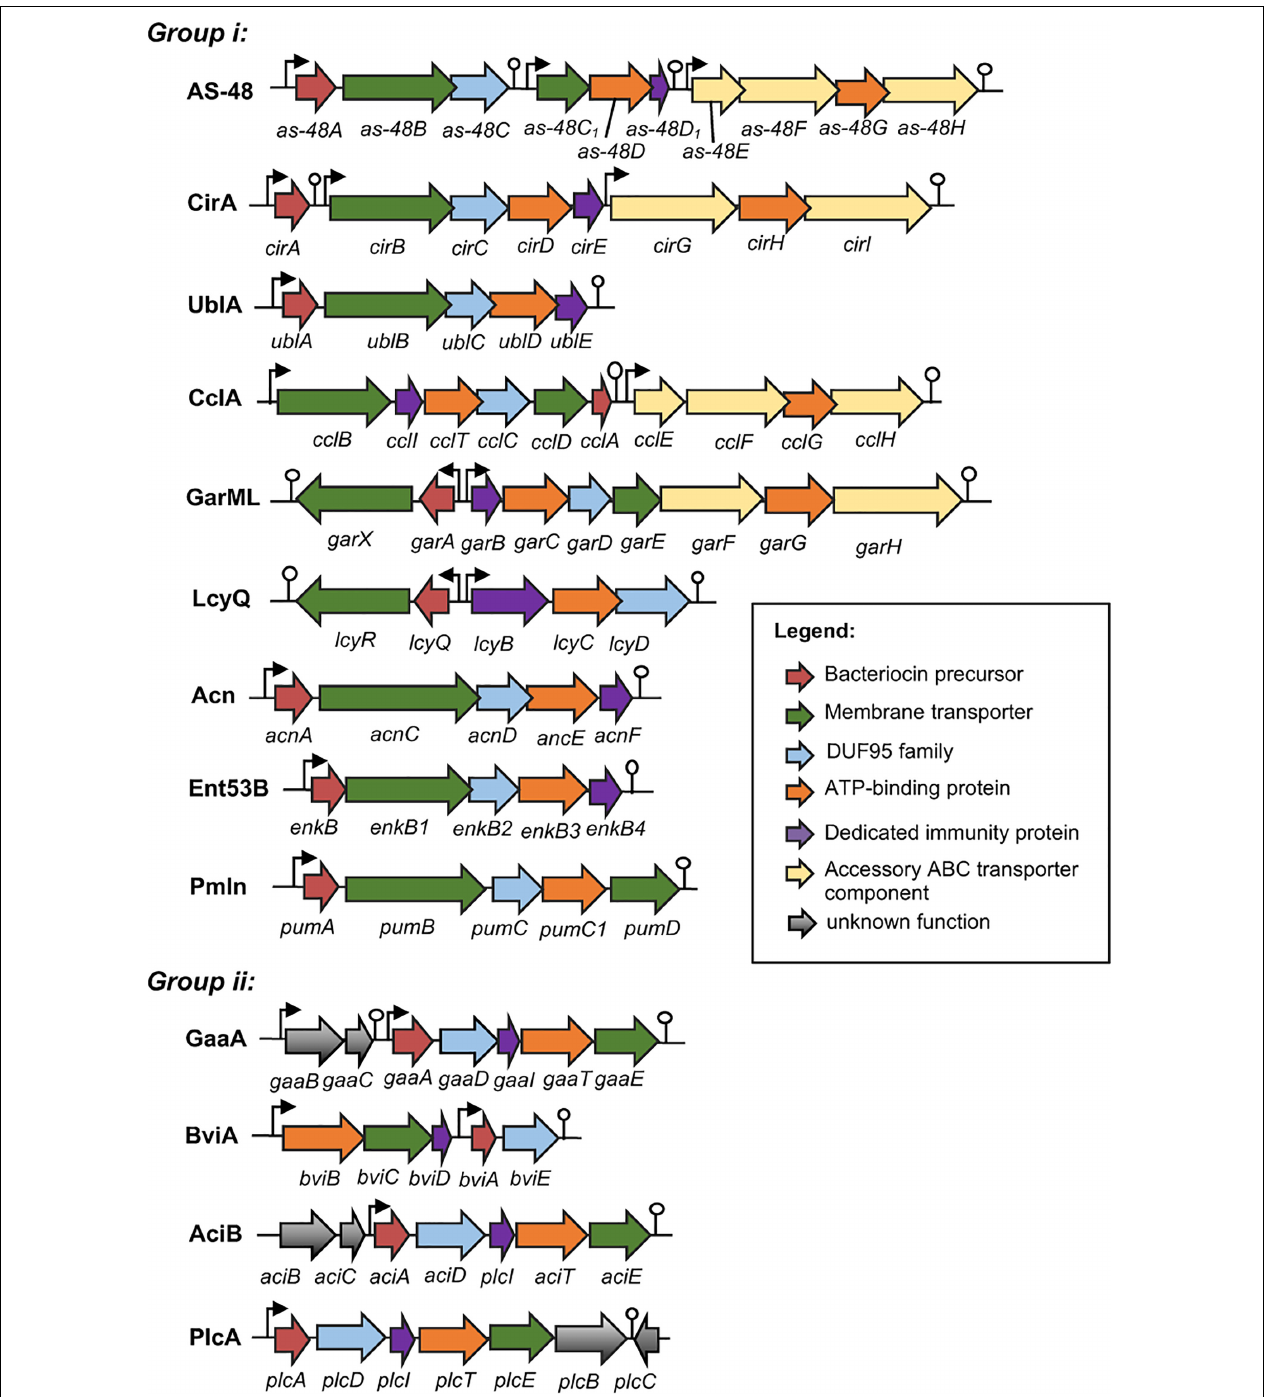
FIGURE 2 | Biosynthetic gene cluster of circular bacteriocins. Genes are color coded based on their known and putative functions as indicated. Abbreviation of bacteriocins are shown in the legend of Figure 1 . The bent arrows and lollipop symbols represent putative promoters and putative terminators, respectively. Figures are not drawn in